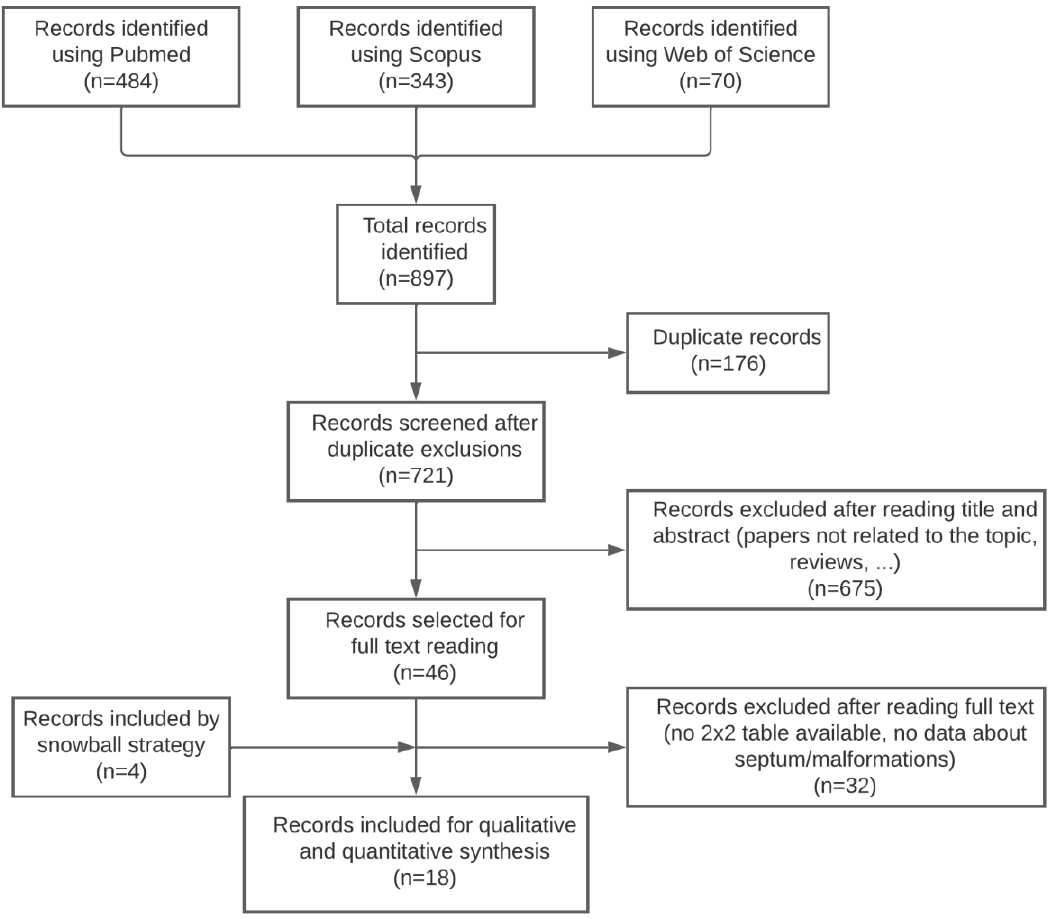
Figure 1. Flowchart showing the study selection process, indicating the titles found in each database, the exclusion process, and the final number of articles included in the meta-analysis.